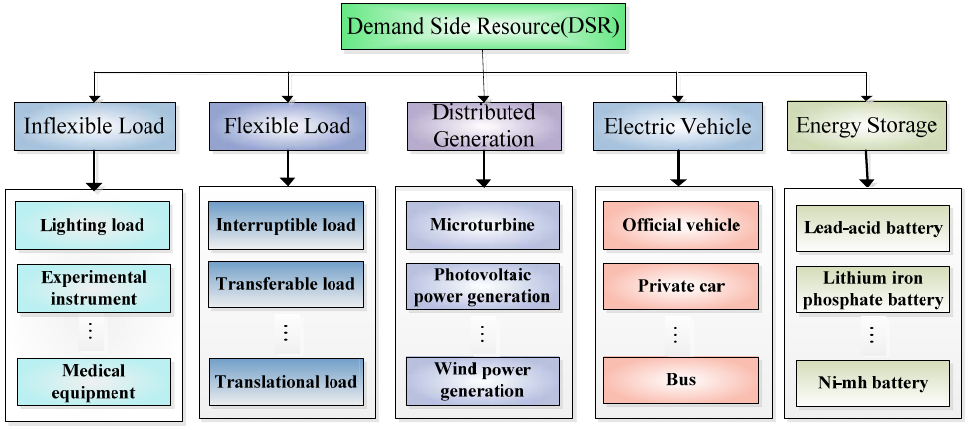
Figure 1. The DSR composition.